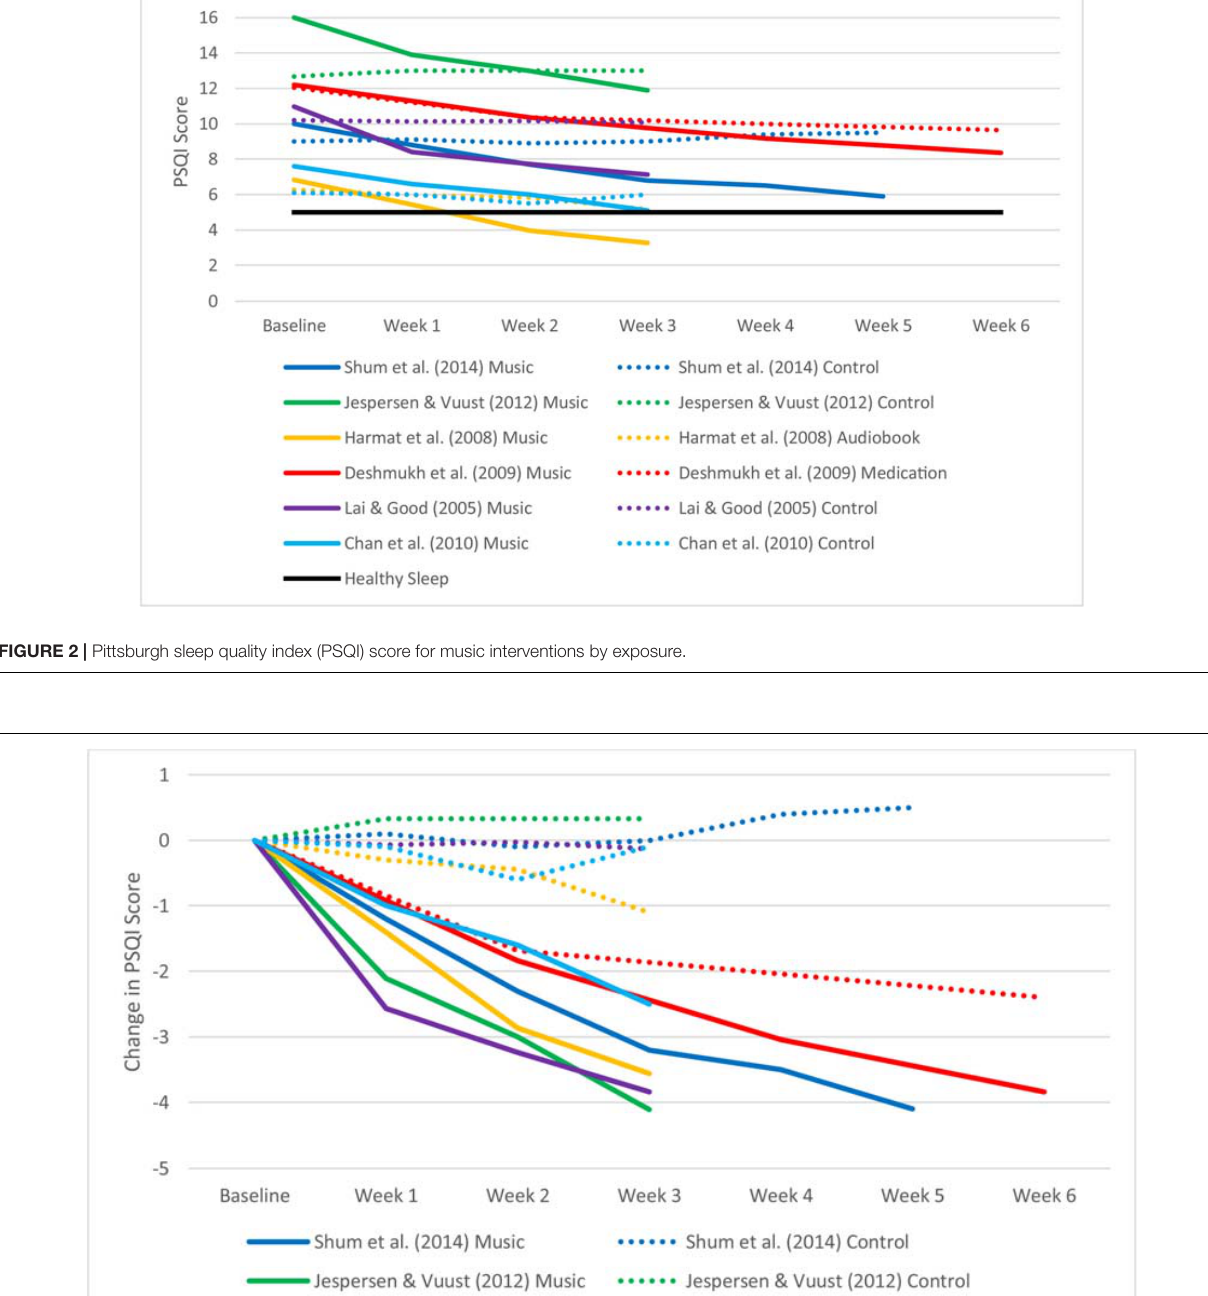
Frontiers in Psychology |